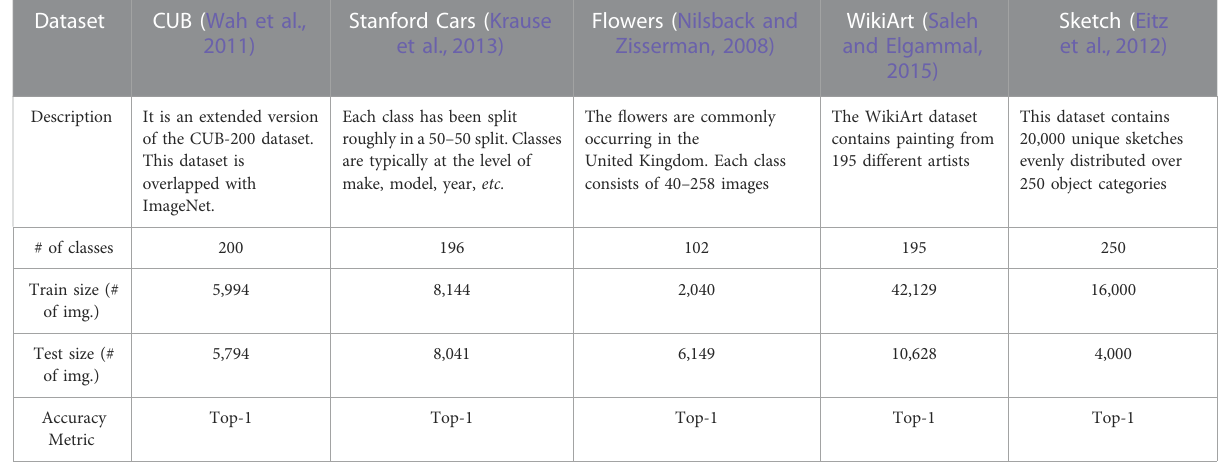
TABLE 1 Datasets examined in experiments. Dataset